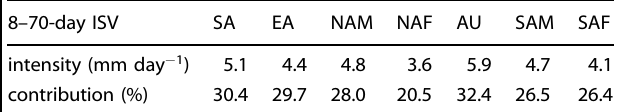
Table 1. Averaged ISV intensity (measured by the standard deviation of 8 – 70-day bandpass- fi ltered precipitation anomalies shown in Fig. 1) and fractional variance contribution of ISV to the total daily variance for each regional land summer